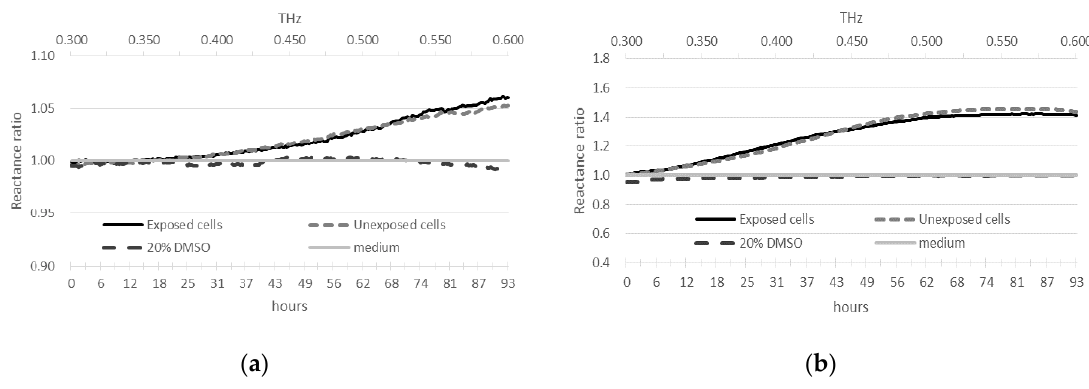
Figure 4. Growth curves of cells that have been exposed to 0.3 – 0.6 THz waves. The solid line represents exposed cells, the broken line represents unexposed cells, the dash line represents adding 20% of DMSO and the gray line represents the culture medium without cells. Cells were exposed to waves from 0.3 THz to 0.6 THz, increasing at a rate of 1.0 GHz every 18 min and 34 s, over a total of 94 h. ( a ) NB1RGB cell proliferation curve. ( b ) HCE-T cell proliferation curve. Data were independently collected three times and the data measured at each frequency was averaged.